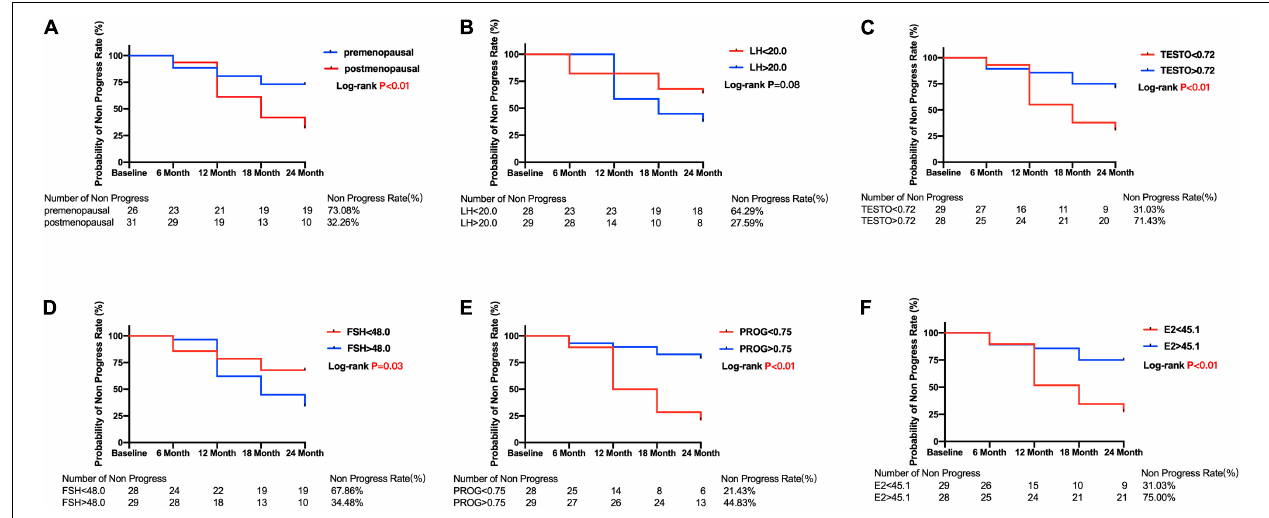
FIGURE 3 | Kaplan–Meier curves for primary open angle glaucoma patients between subgroups divided by menopause or median of sex hormone level. Plots of Kaplan–Meier depicts the probability of no progression in POAG patients in each group. The number of POAG patients without progression in each group was shown below five follow-up time points. (A) Kaplan–Meier curves between premenopausal and postmenopausal group; Kaplan–Meier curves between lower and higher baseline level of LH (B) , TESTO (C) , FSH (D) , PROG (E) , E2 (F) in all POAG subjects. PRL, prolactin; LH, luteinizing hormone; TESTO, testosterone; FSH, follicle-stimulating hormone; PROG, progesterone; E2, 17- β